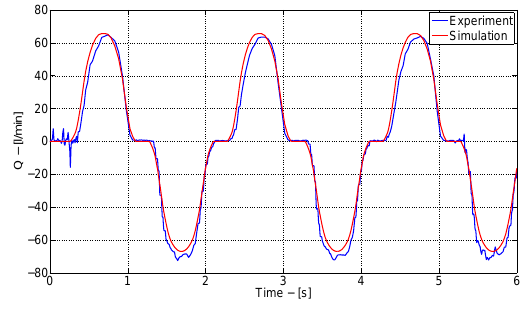
Figure 20: Comparison of simulated and measured valve flow at 0.5